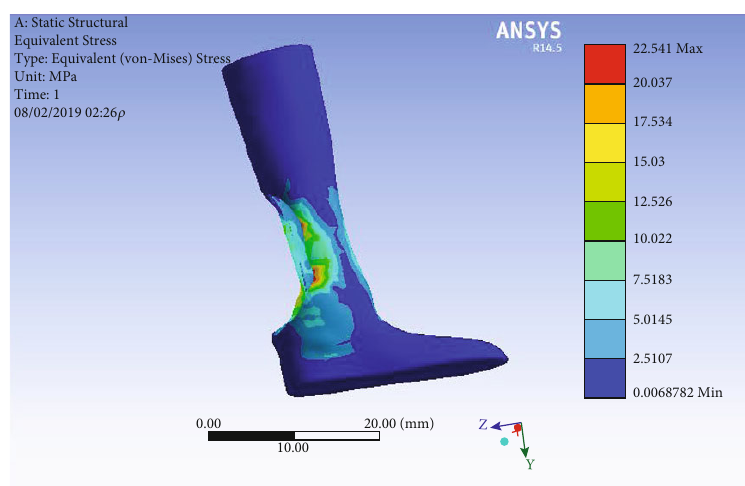
Figure 18: Equivalent stress (von Mises) in group